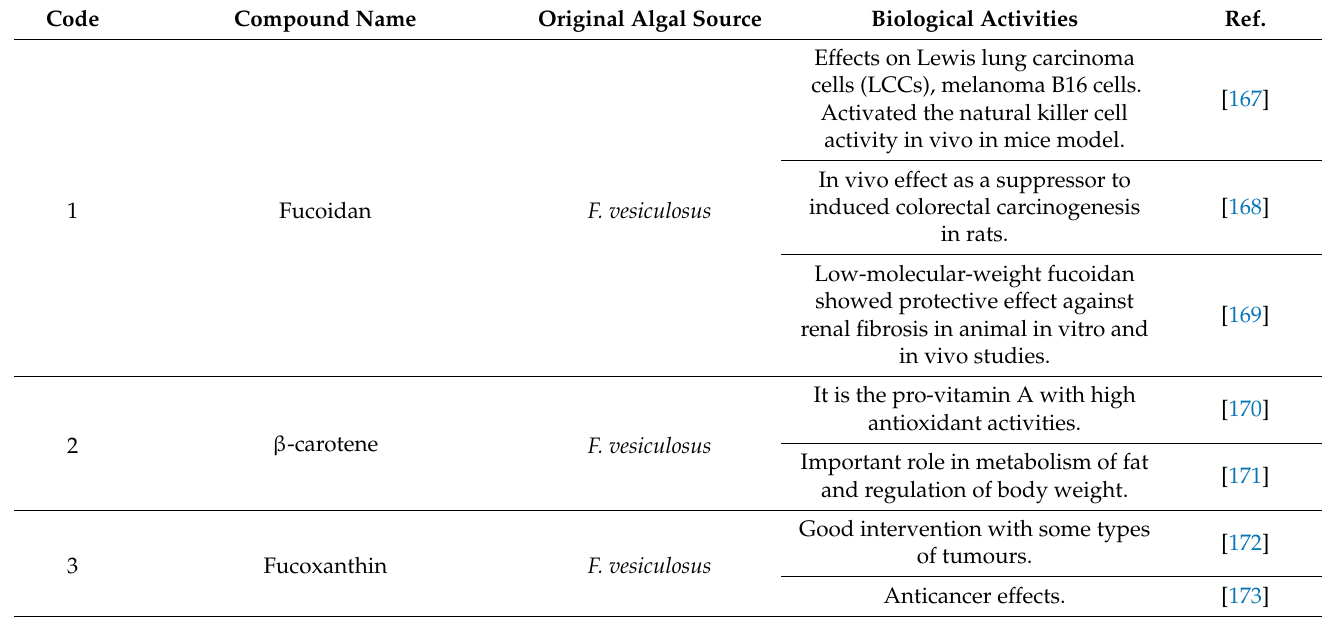
Table 1. Compounds identified in Brown seaweeds (rockweeds) with their biological